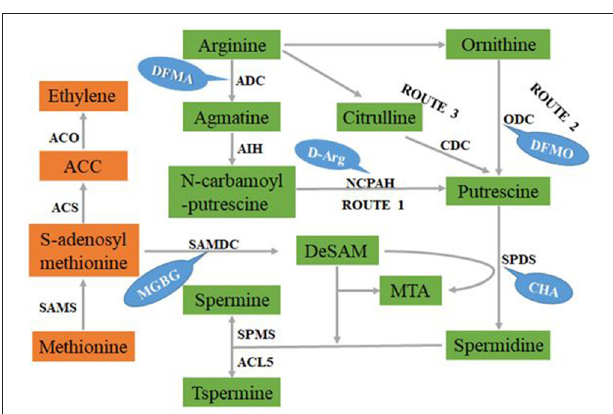
FIGURE 1 | The pathway of PAs biosynthesis in plant. The orange part is the ethylene synthesis pathway, and the green part is the polyamine synthesis pathway (There are three routes of putrescine synthesis, route 1, route 2, and route 3), and the blue part is the corresponding enzyme inhibitor.